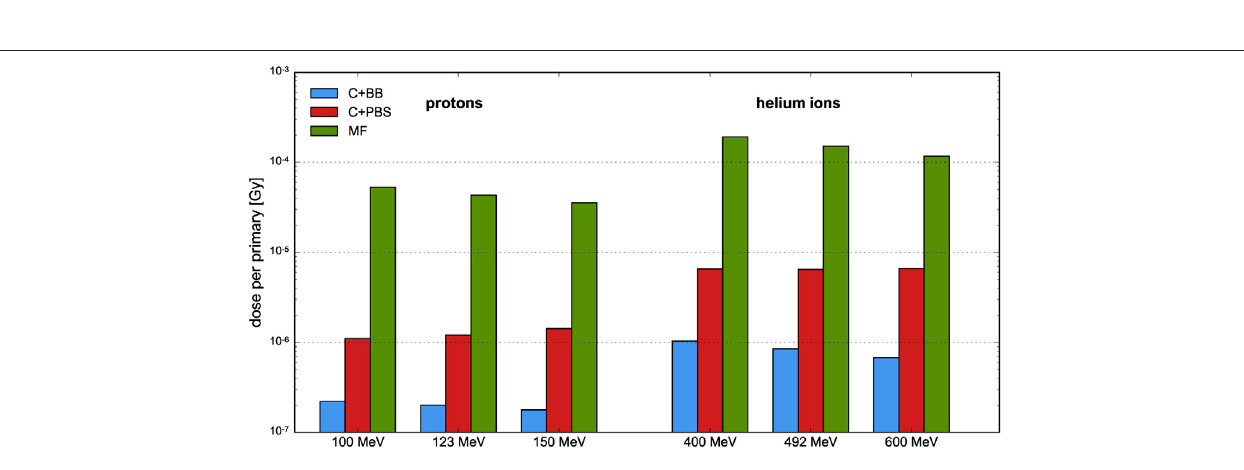
Frontiers in Physics |